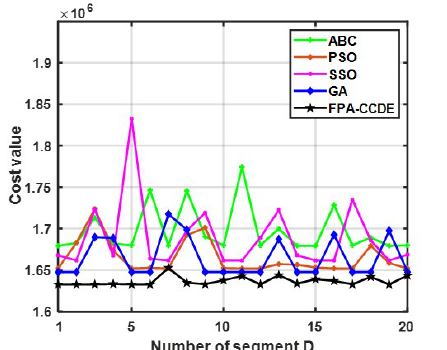
Figure 9. Local amplification of